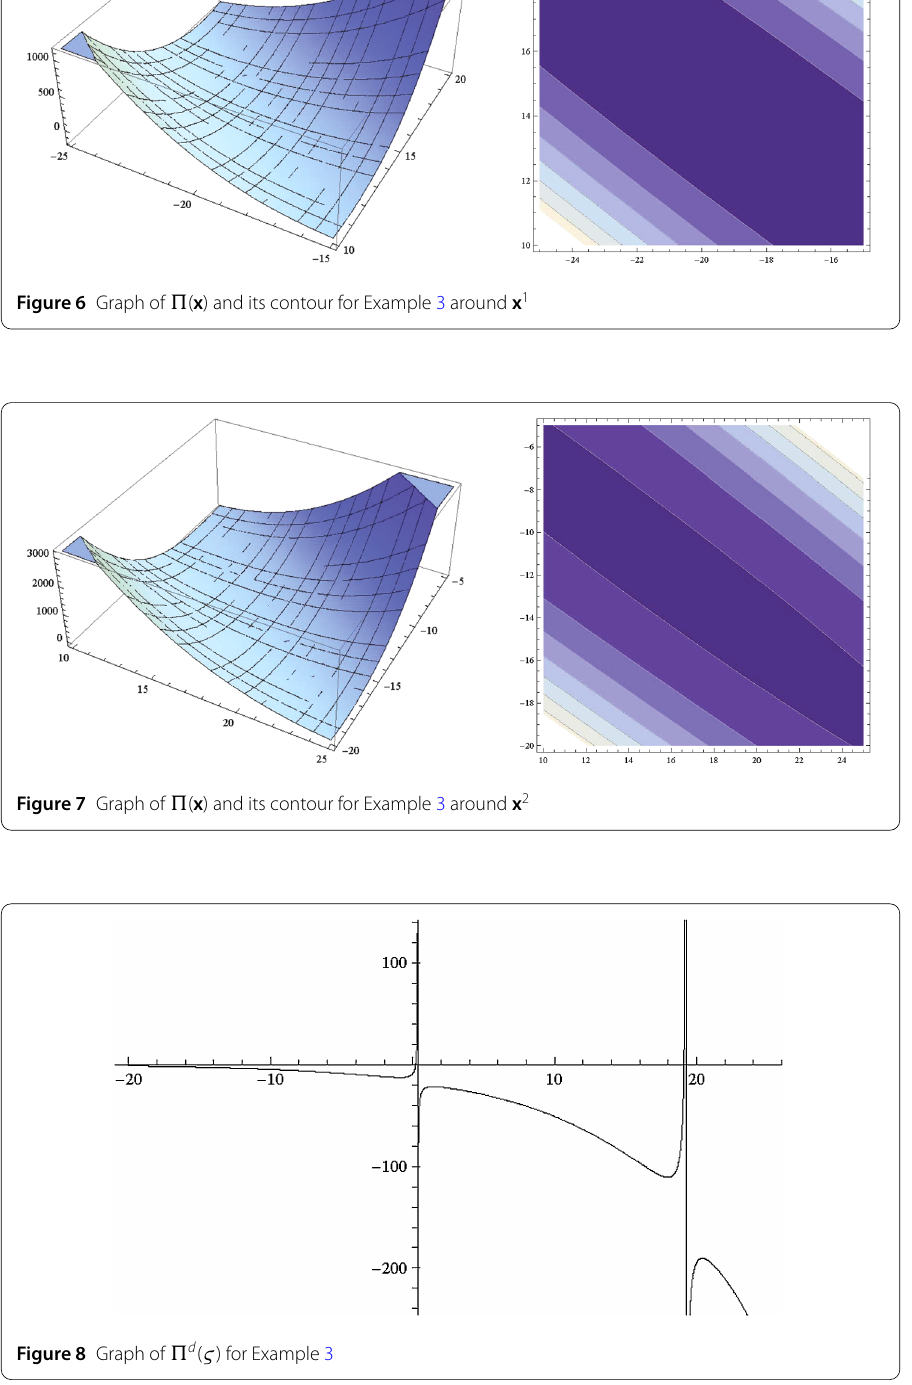
Since F ( x ) is a potential operator, these stationary points are all fixed points of F ( x ). It is easy to find that the matrix G ( ς ) has two singularity points: ς 1 = 19.266 and ς 2 =